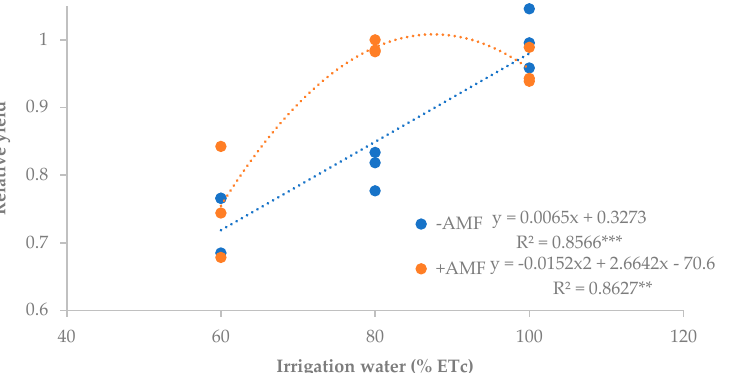
Figure 9. Relationship between relative yield (yield/maximum yield) and irrigation water of inocu- lated (+AMF) and uninoculated ( − AMF) melon plants during two years of experiments. ** signifi- cant at p < 0.01; *** significant at p < 0.001.